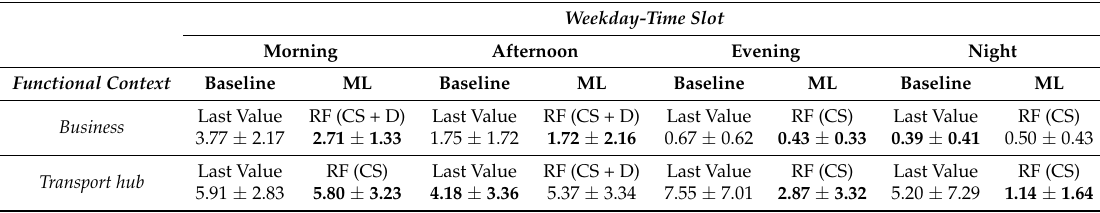
Table 3. Comparison between ML-based and baseline solutions in terms of MAE (avg ± std) for different time slots on weekdays.